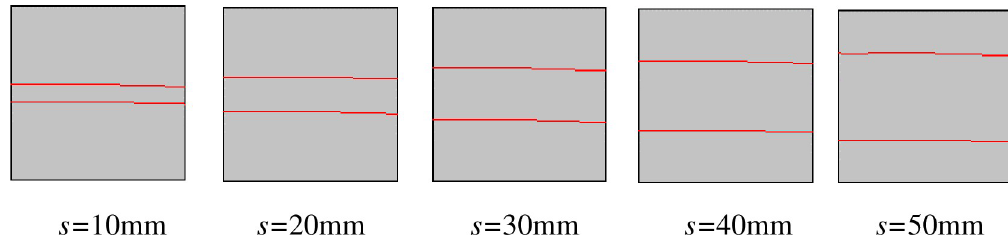
Fig 2. Simulation model of different parallel-joint spacings when the rock size l is 100 mm × 100 mm.